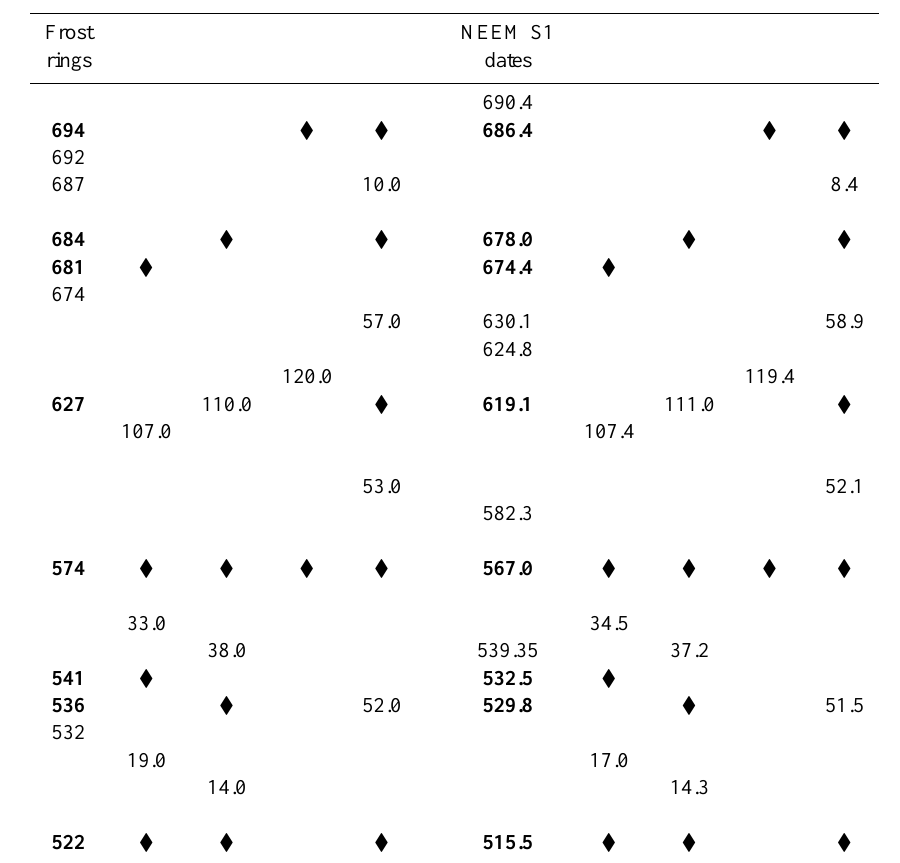
Table 2. Comparison of intervals between frost ring dates (Salzer and Hughes, 2007) and NEEM S1 acid start dates (Sigl et al., 2013). The values between successive diamonds ( (cid:7) ) in each column are the intervals between specific frost ring dates and specific ice acid dates. The similarity of the intervals suggests that the dates marked in bold are signals of the same event, indicating that ice core dates in this period are 7 years too old.